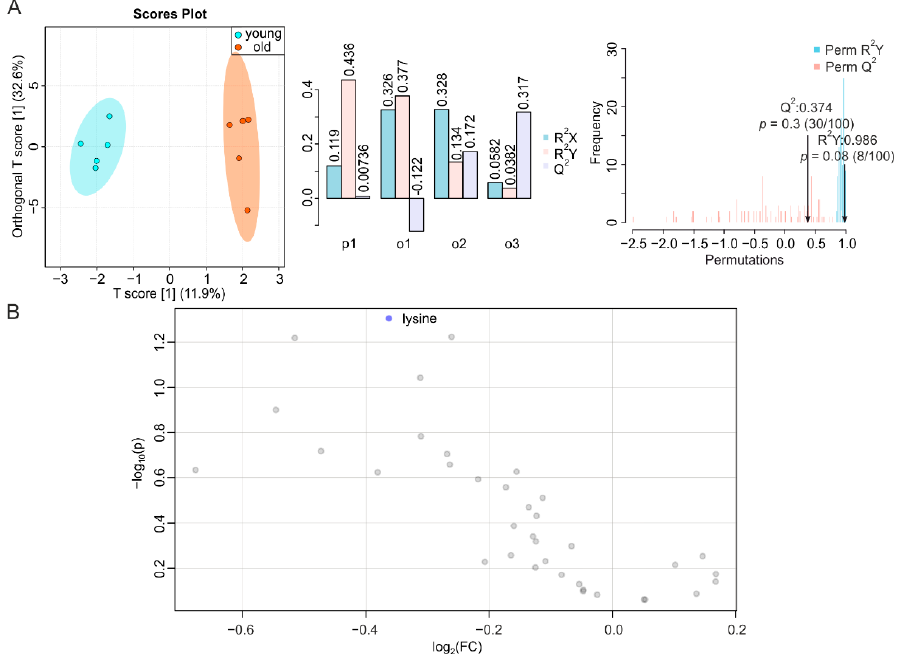
Figure 5. NMR-based metabolomics analysis of duodenum. ( A ) O-PLS-DA plot and cross validation of duodenum samples from young (blue) and old (orange) mice (left), with n = 5 each, and permu- tation between the predictive component (p1) and three orthogonal components (o1, o2, o3) with cross-validated R 2 X, R 2 Y, and Q 2 coefficients (middle), and histogram showing permutation test with permutation number n = 100 (right). ( B ) Volcano plot of differentially regulated metabolites in the duodena of young and aged mice. Decreased (blue) metabolites delimitate the fold change over aging, while grey dots denote insignificantly changed metabolites.